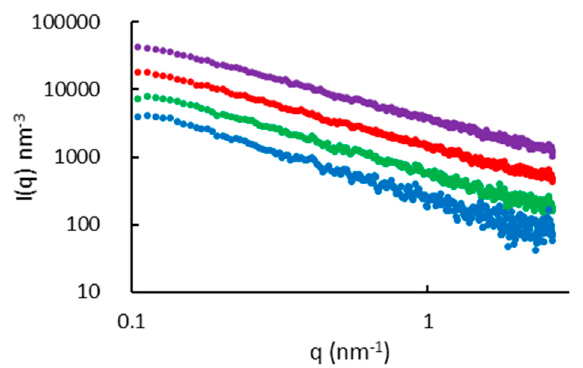
Figure 4. SAXS patterns of WSCA solutions in water, at concentrations, from bottom to top, of 1, 1.5, 2, 2.5 wt% (the plots have been spaced for clarity: 1.5% by 2, 2% by 3 and 2.5% by 5).